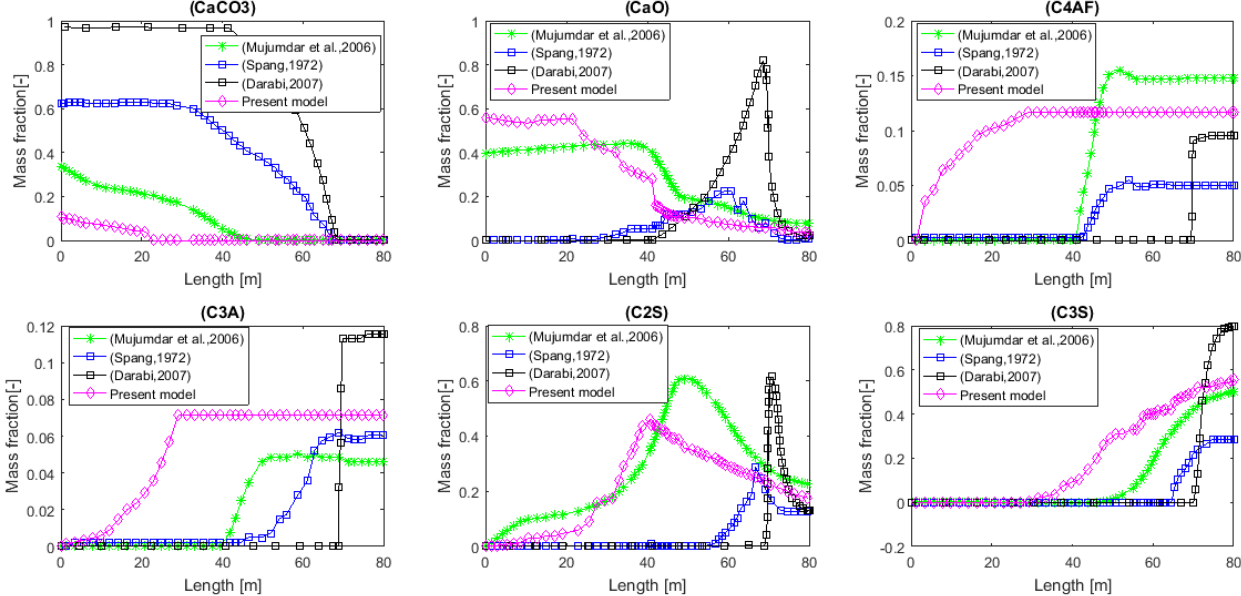
Figure 9. Meal composition profiles comparing current predictions to those in the literature.